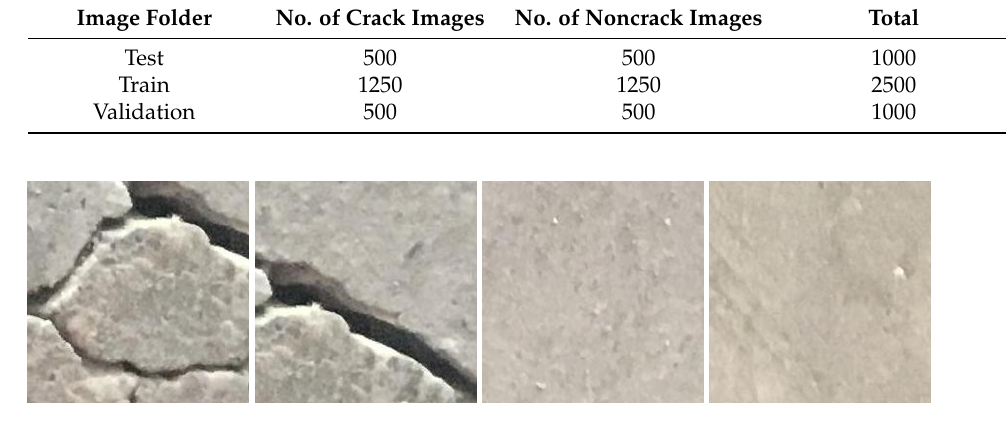
Figure 15. Sample crack and non-crack images of external dataset.